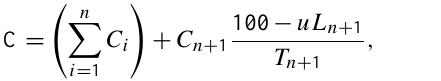
Figure 1. Location of the 942 profiles established in non crop areas (grey colour) of peninsular Spain and used in the present study.